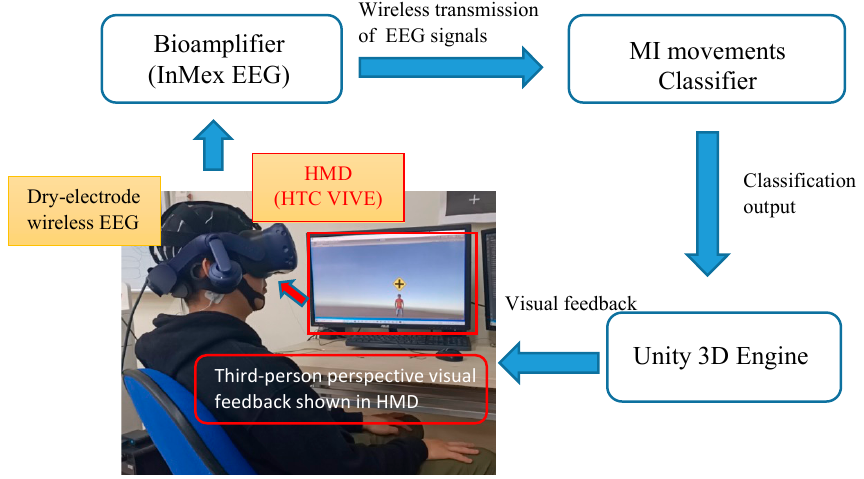
Figure 1. The system architecture of the proposed BCI system with immersive VR feedback.